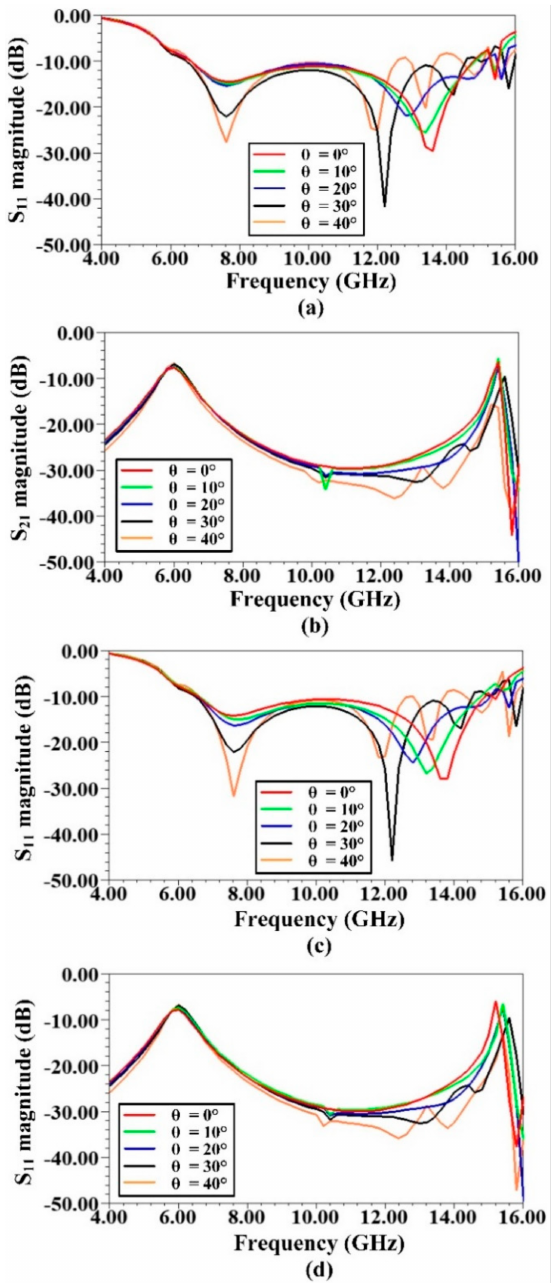
Figure 3. Unit cell response to oblique angle incidences of TE/TM wave polarizations. ( a ) Reflection response for TE wave. ( b ) Transmission response for TE wave. ( c ) Reflection response for TM wave. ( d ) Transmission response for TM wave. (All results shown for AP L = 5